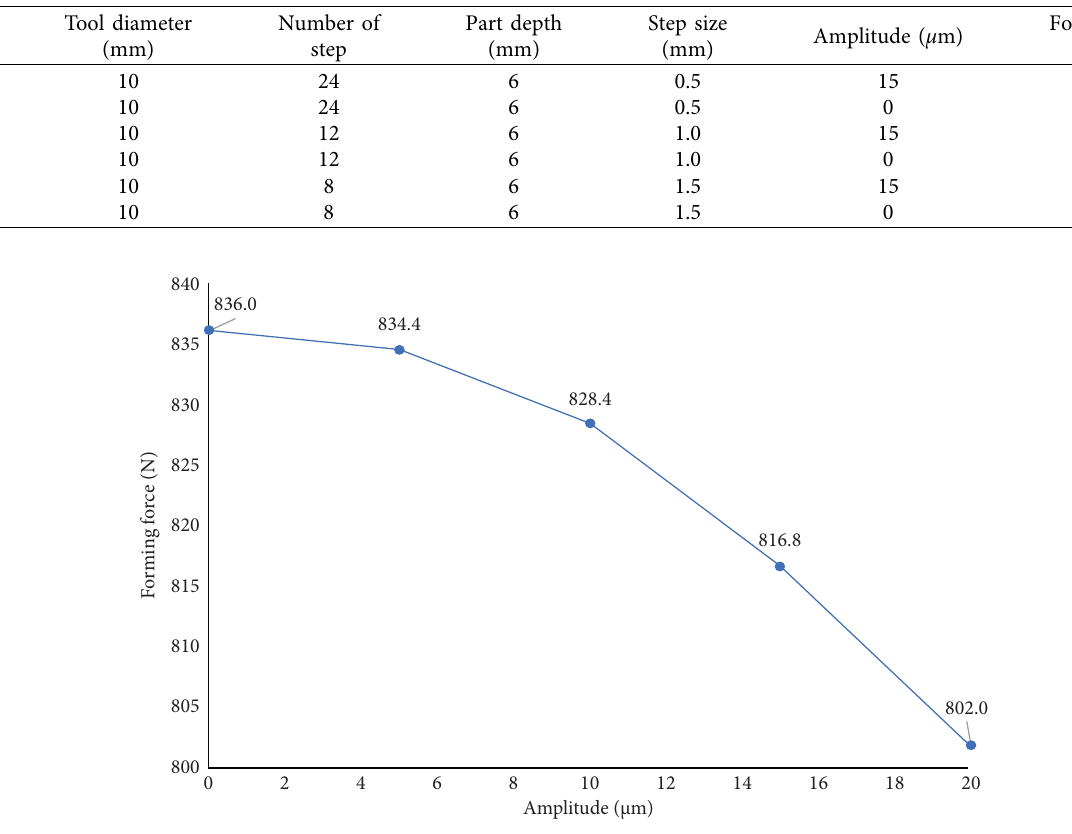
Figure 14: Forming force with diferent vibrating